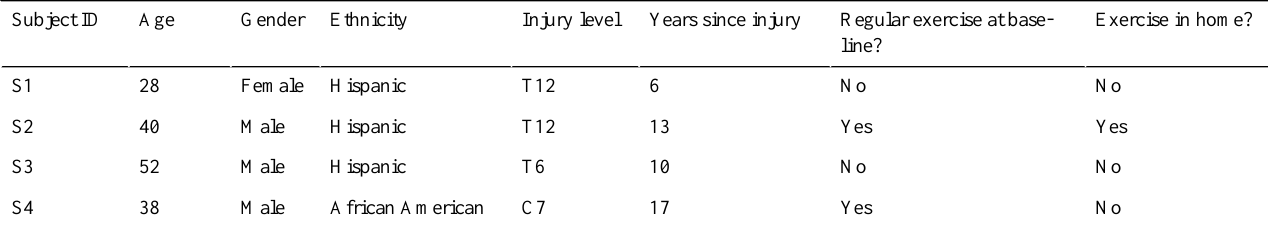
Table 3. Demographics of study